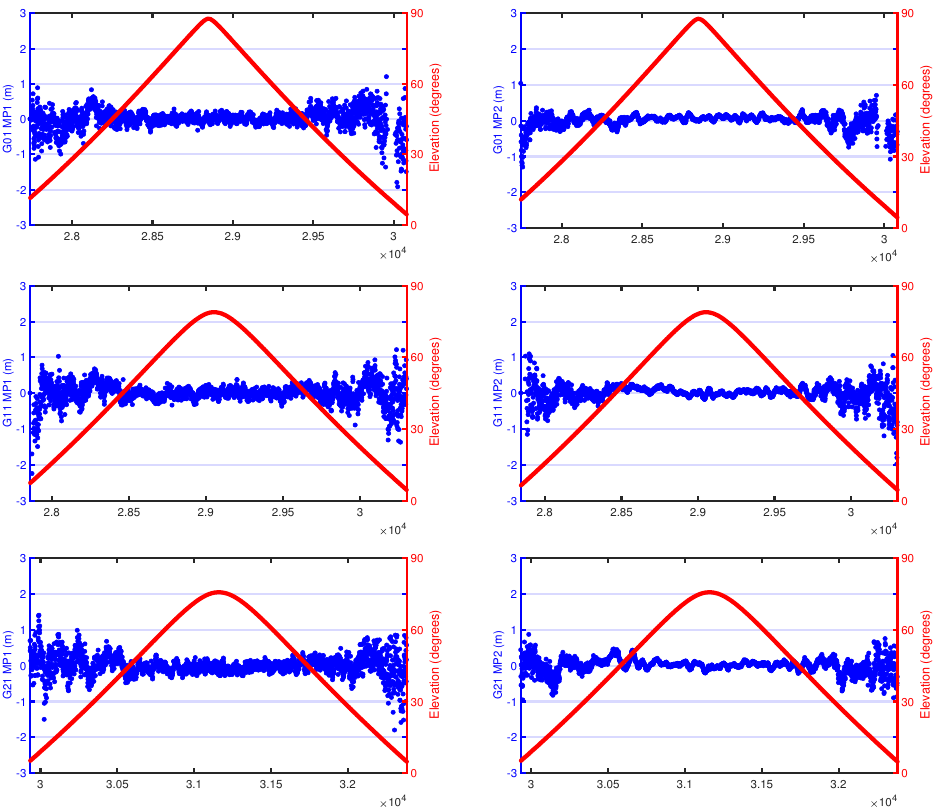
Figure 4. An example of an MPC time series for C1 and P2 observations and elevation-angle variations of complete passes for three different GNSS